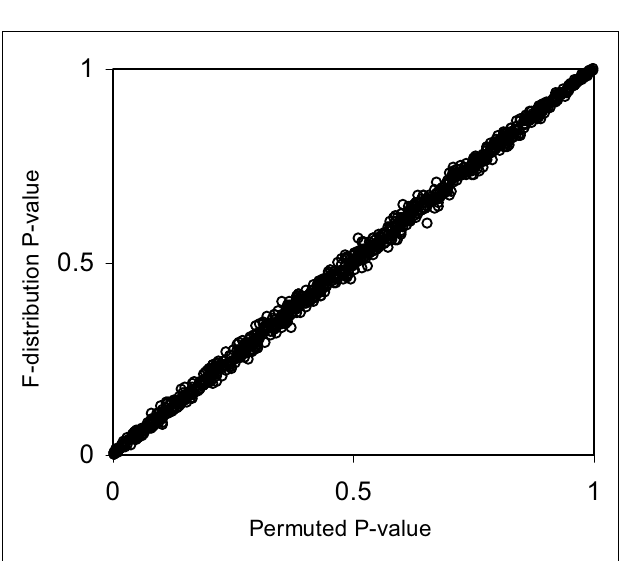
FIGURE 2 | Scatter plot of p -values from Figure 1 generated from permutation tests vs. those derived from the F -distribution (Pearson correlation coefficient =